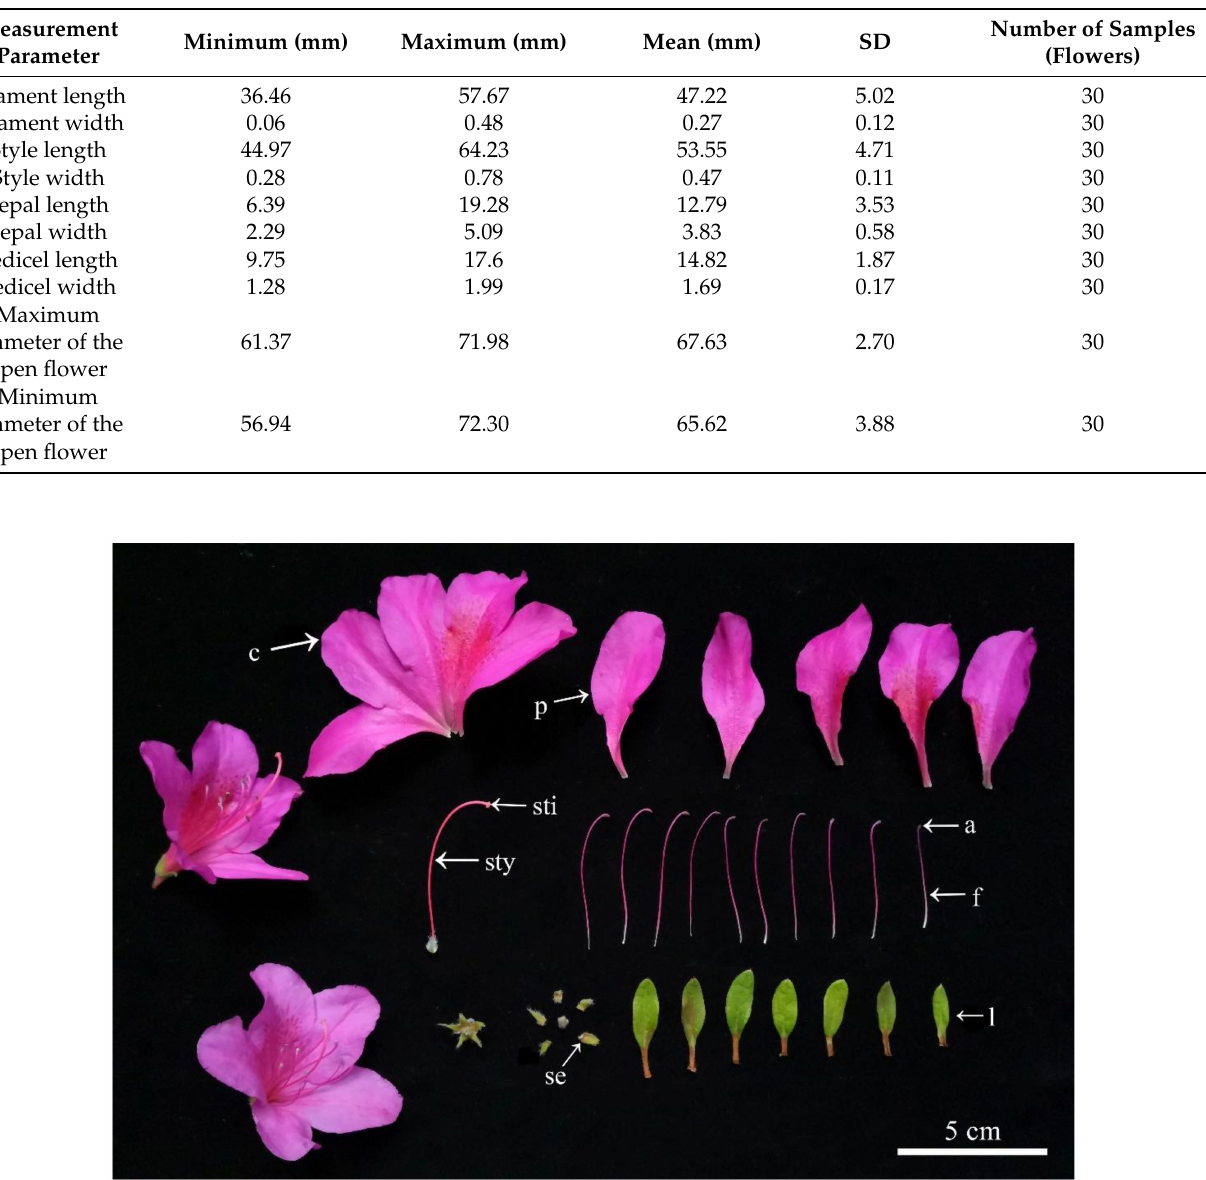
Table 1. Measurements of the various parts of floral organs.